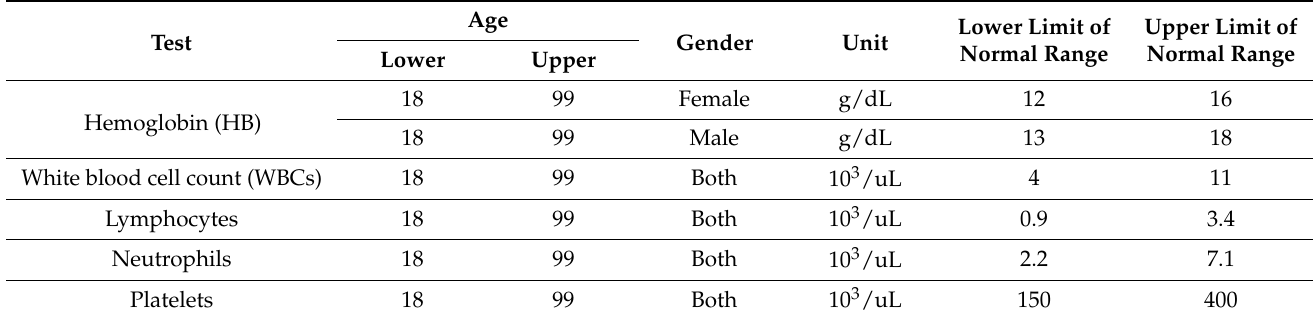
Table A1. Laboratory tests normal